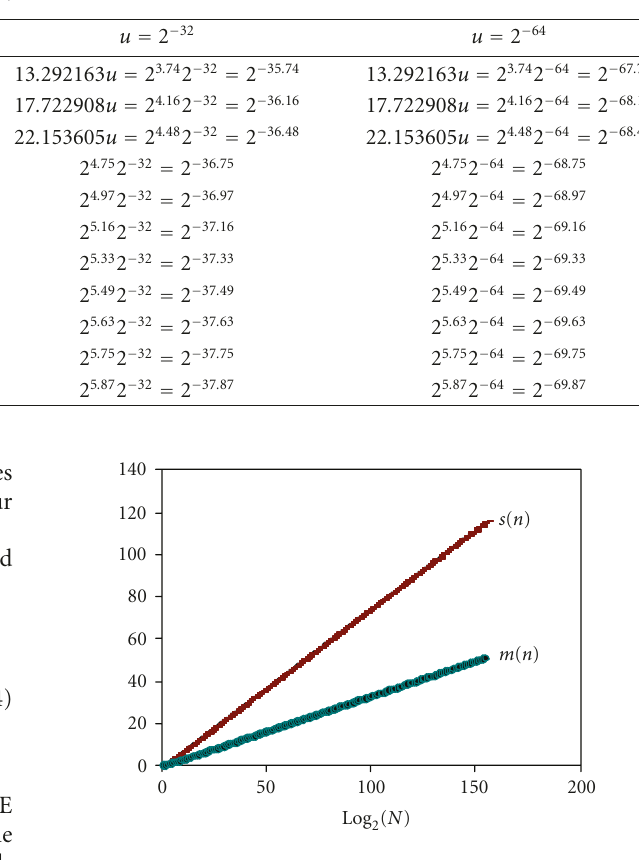
Table 13: Normwise forward stability of DHT-I ( N ) for 16, 32, and 64 bits data.